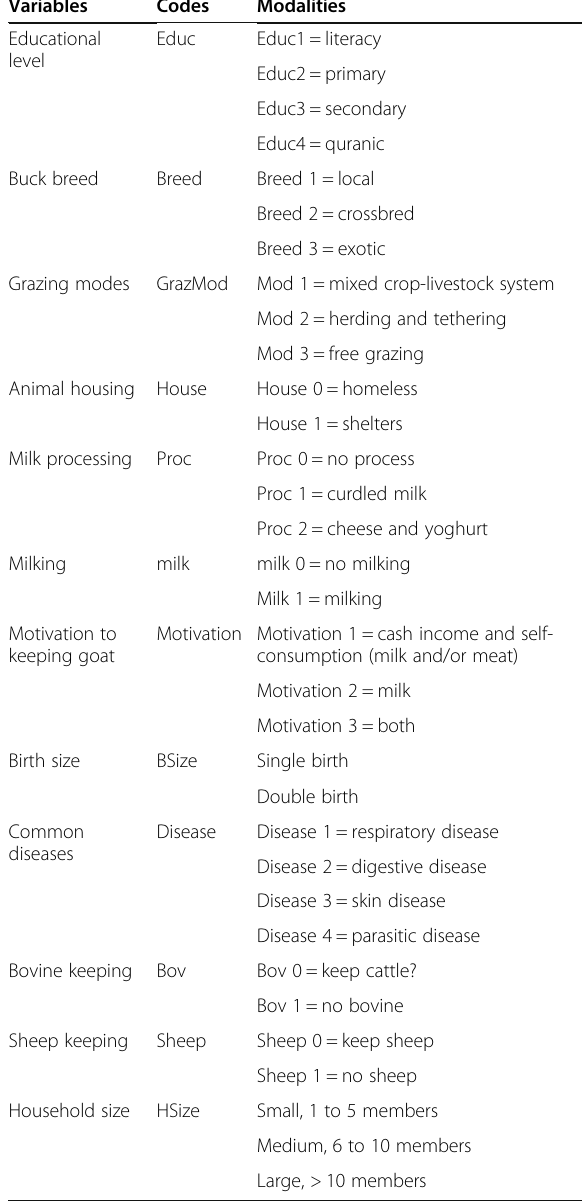
Table 1 List of qualitative variables used in the MCA